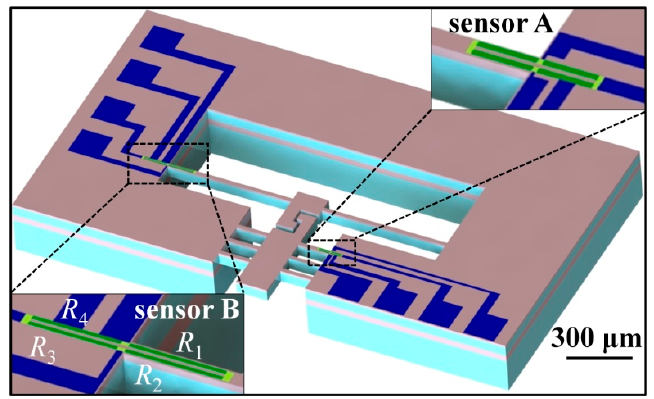
Figure 2. Sketch of the micro-electromechanical systems (MEMS) device with piezoresistive sensors.